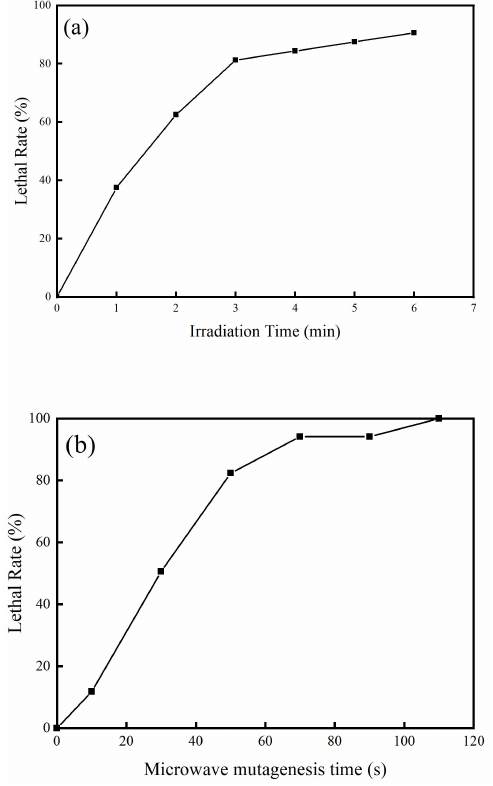
Figure 4. Lethal rate curve for UV ( a ) and microwave ( b ) mutagenesis.